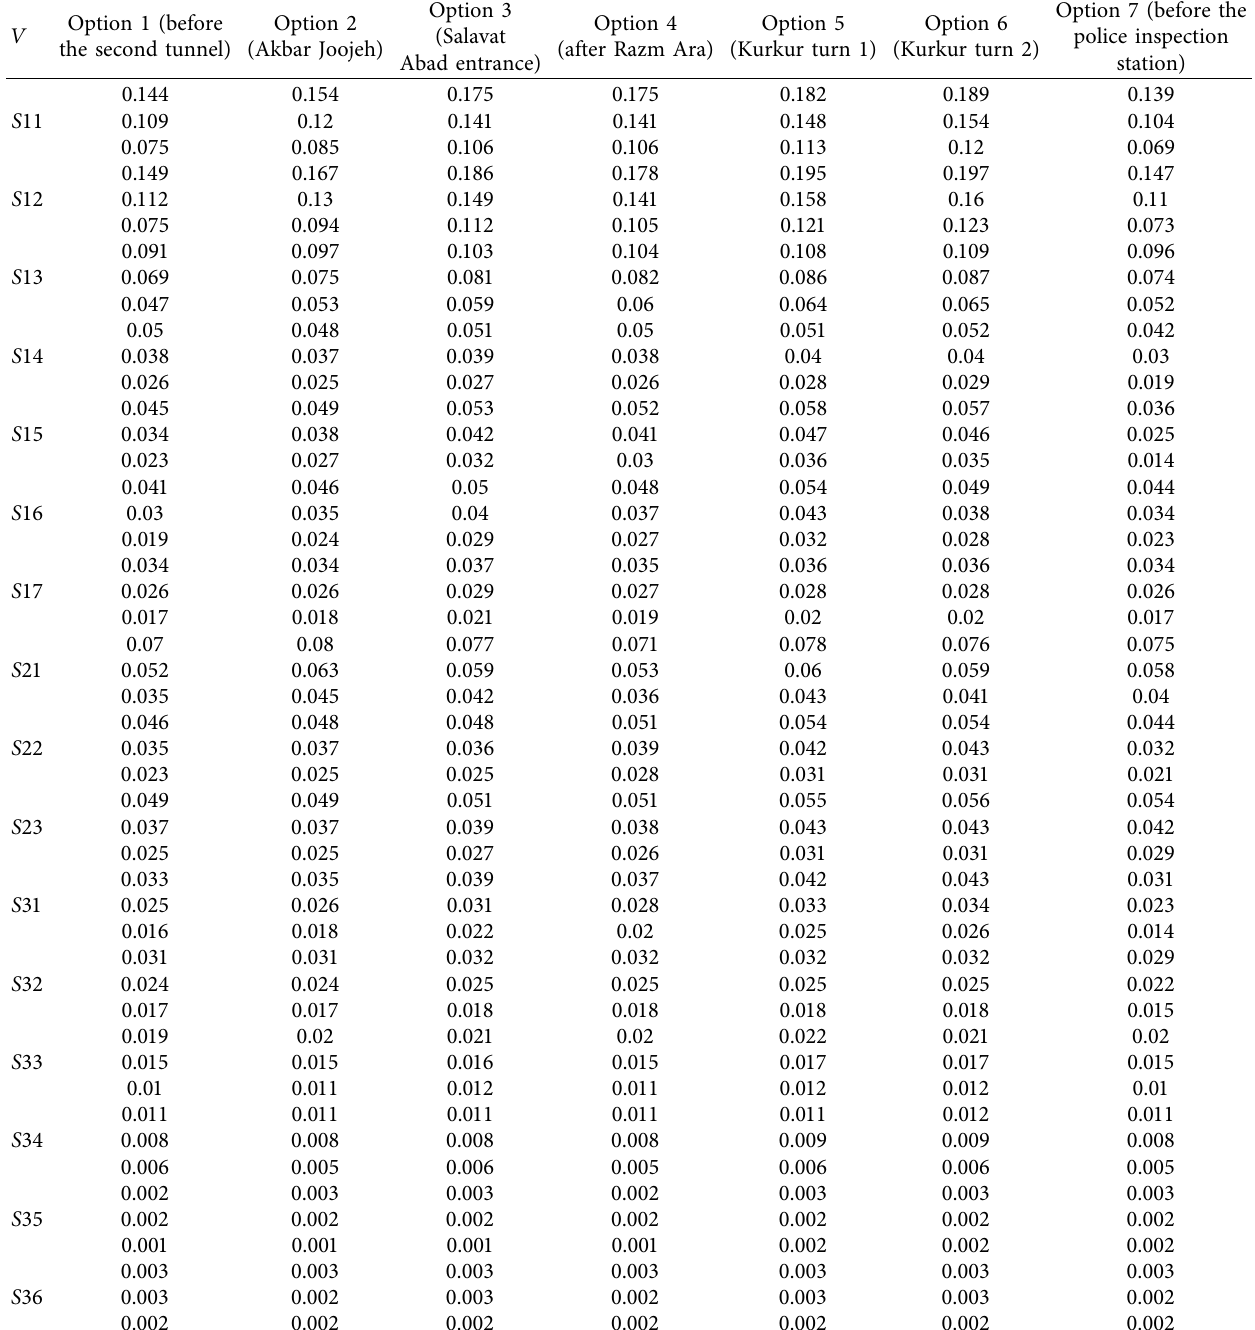
Table 14: Weighted unscaled matrix V